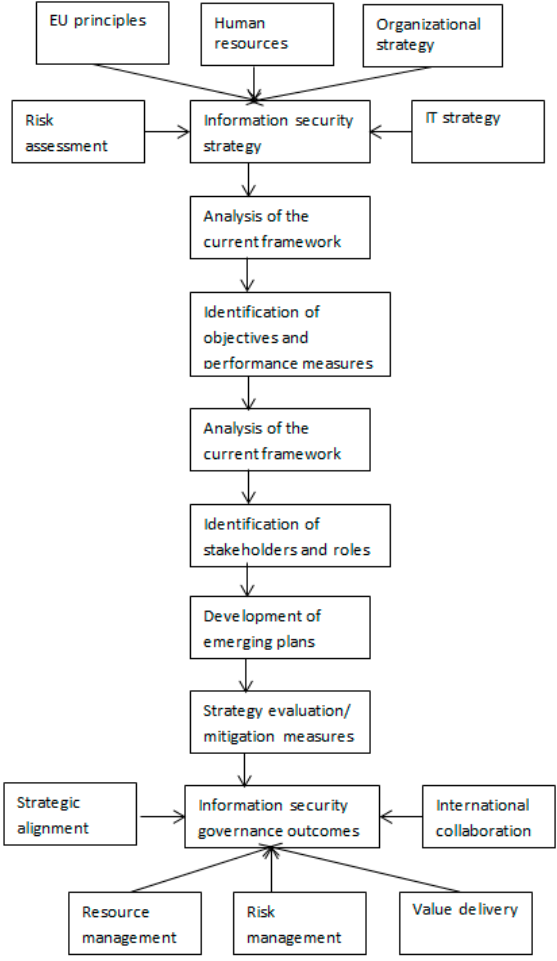
Figure 1. Suggested framework for National Cybersecurity Strategy.